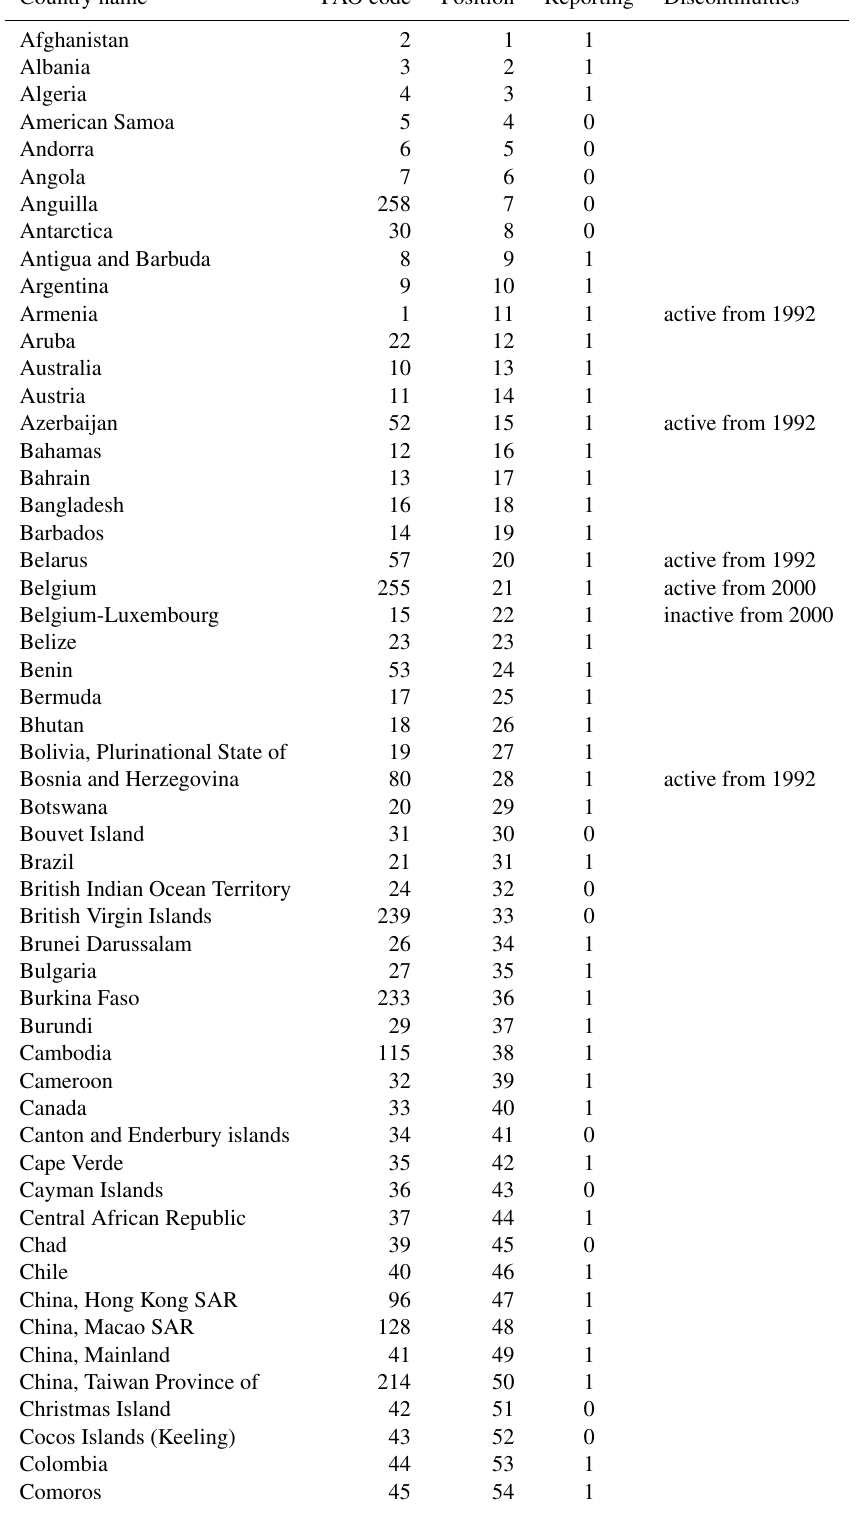
Table A2. List of countries in the CWASI